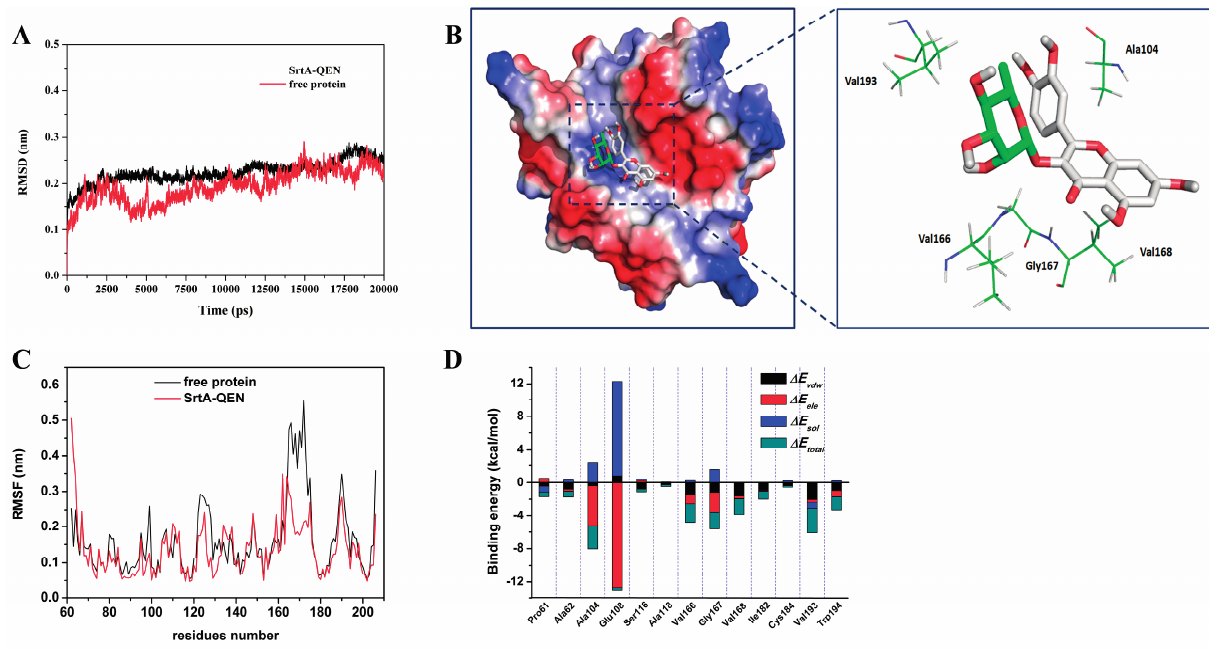
Figure 3. Structures of the screening compounds. ( A ) The root-mean-square deviations (RMSD) of all the atoms of SrtA-QEN complexes with respect to their initial structures as a function of time. ( B ) The predicted binding mode of QEN in the SrtA binding pocket obtained from the MD simulation. ( C ) RMSFs of residues of the whole protein in the SrtA-QEN complex and free SrtA during the last 10-ns simulation. ( D ) Decomposition of the binding energy on a per-residue basis in the SrtA-QEN